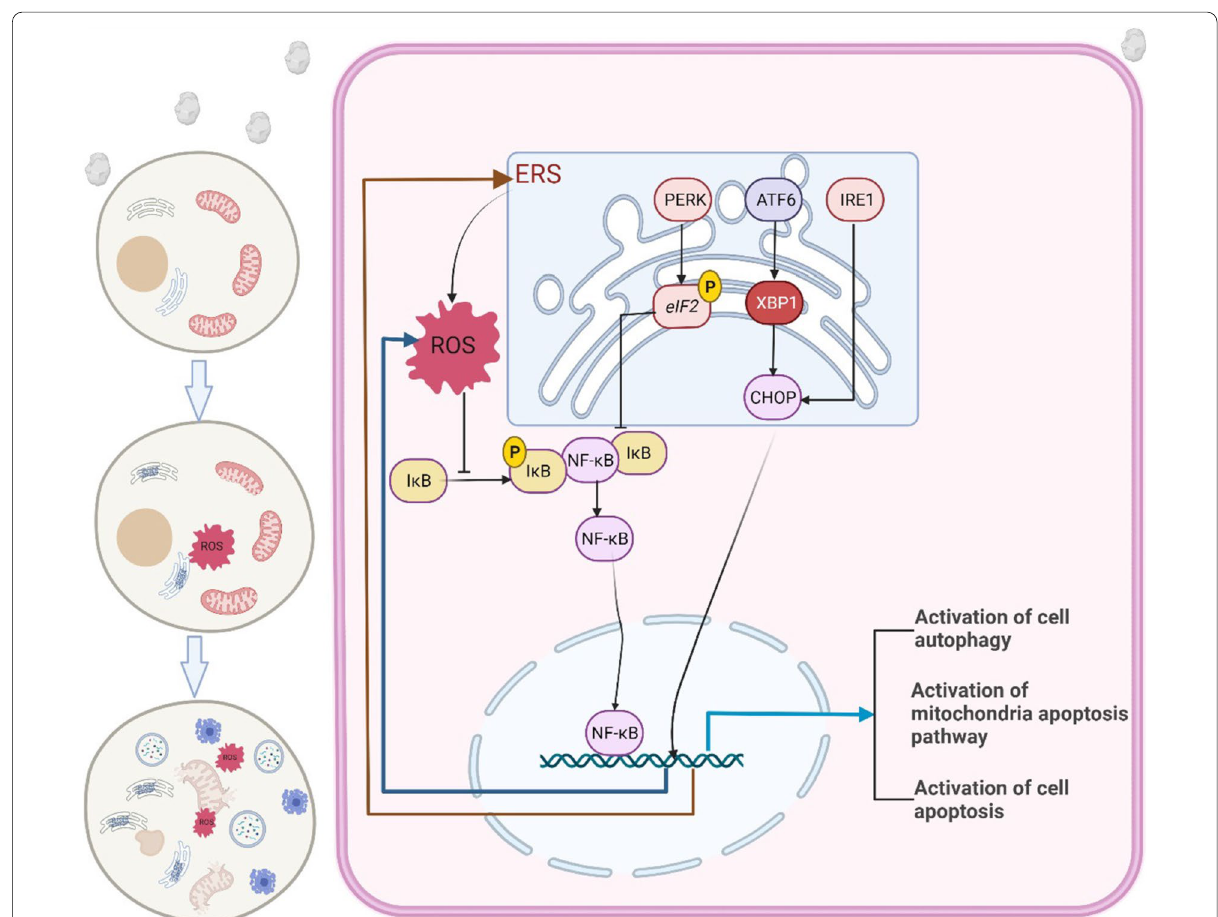
Fig.1 Oxalate induces renal tubular epithelial cell injury by activating ERS/ROS/NF-κB signaling